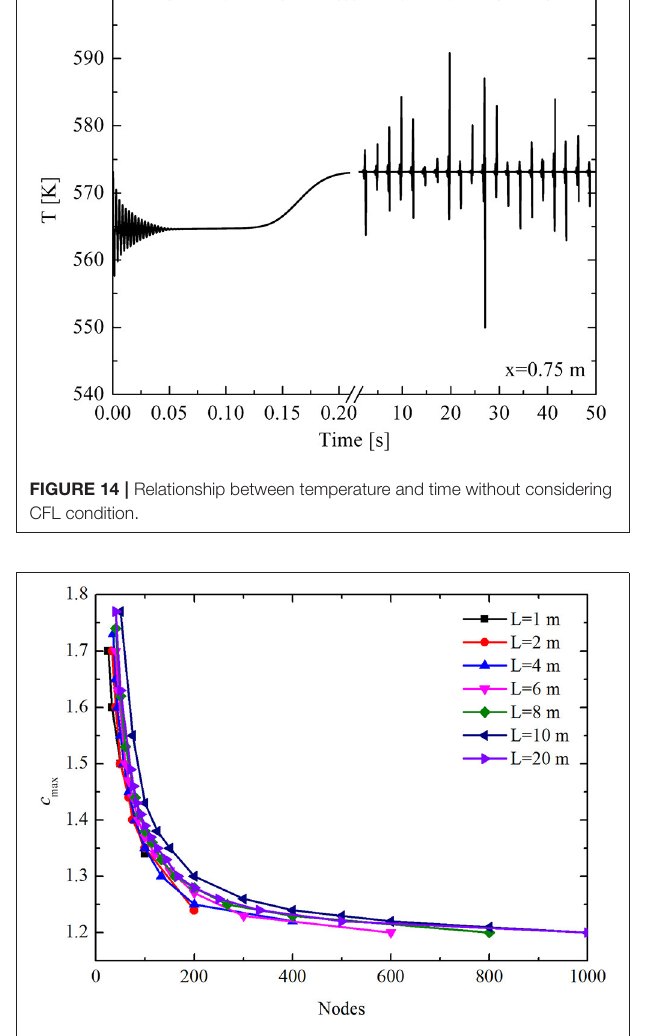
FIGURE 15 | Relationship between c max and node number under different pipe length.